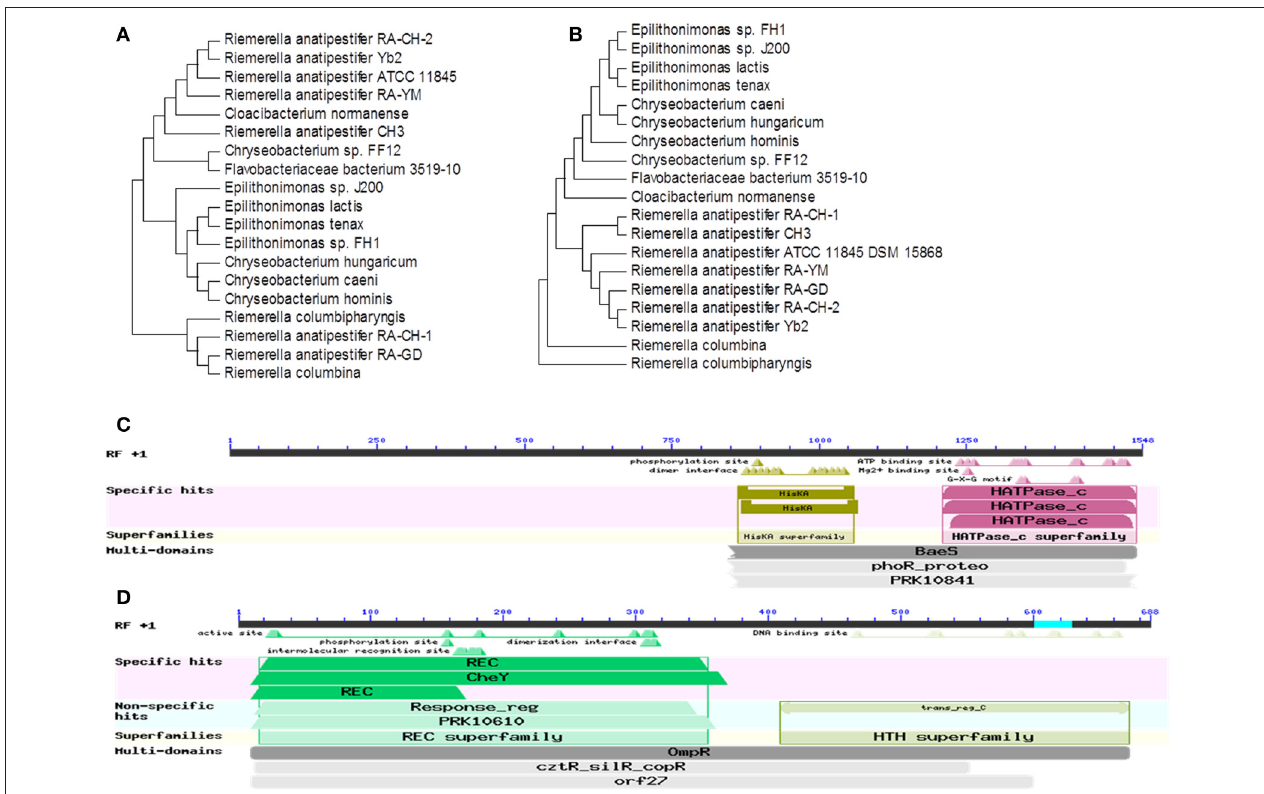
FIGURE 1 | Analys is of the RAYM_RS09735 and RAYM_RS09740 homology in R. anatipestifer. The bootstrap percentage from 1,000 replicates is indicated at each node. Rooted neighbor-joining tree of the amino acid sequences of RAYM_RS09735 (A) and RAYM_RS09740 (B) . Bioinformatics analysis the conserved domains of RAYM_RS09735 (C) and RAYM_RS09740 (D) .